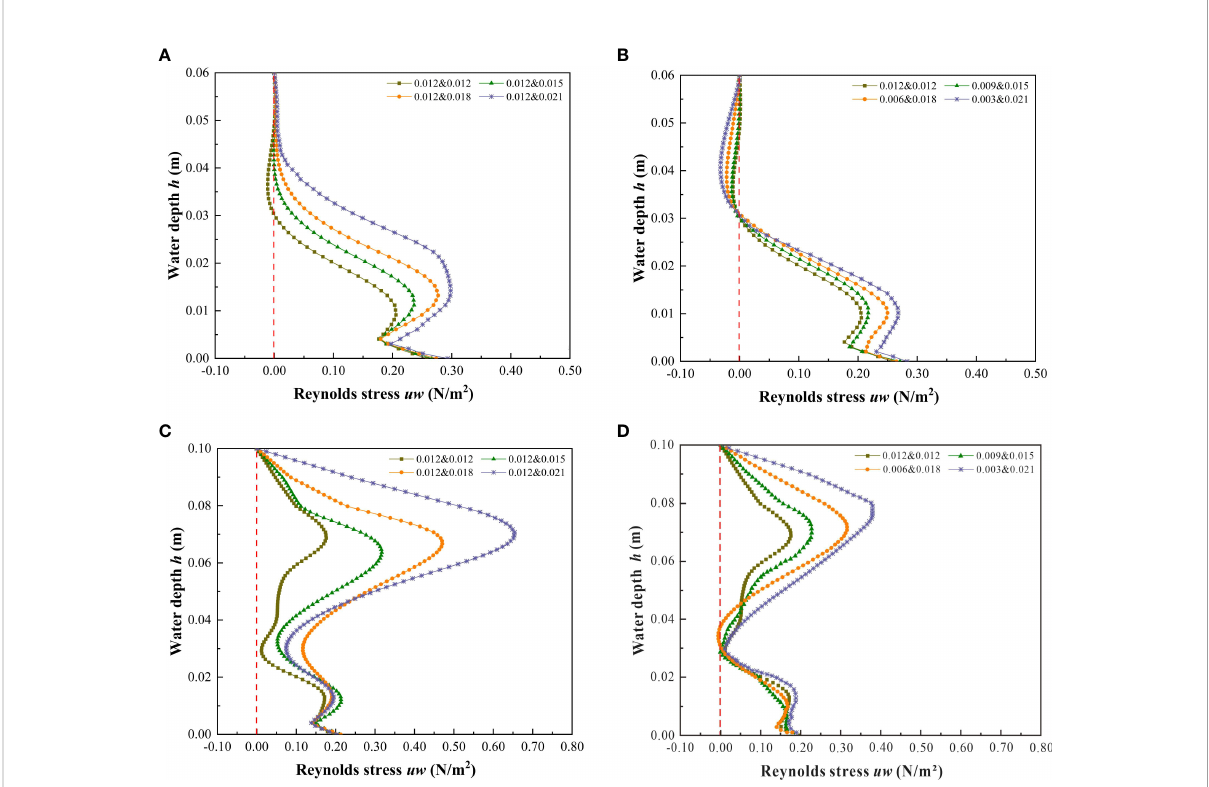
FIGURE 12 Vertical distribution of Reynolds stress at the location of vegetation patch channel P 1 under different submerged states. (A) h = 0.06 m, vegetation combination distribution, non-submerged vegetation, (B) h = 0.06 m, vegetation discrete distribution, non-submerged vegetation, (C) h = 0.10 m, vegetation combination distribution, submerged vegetation, (D) h = 0.10 m, vegetation discrete distribution, submerged